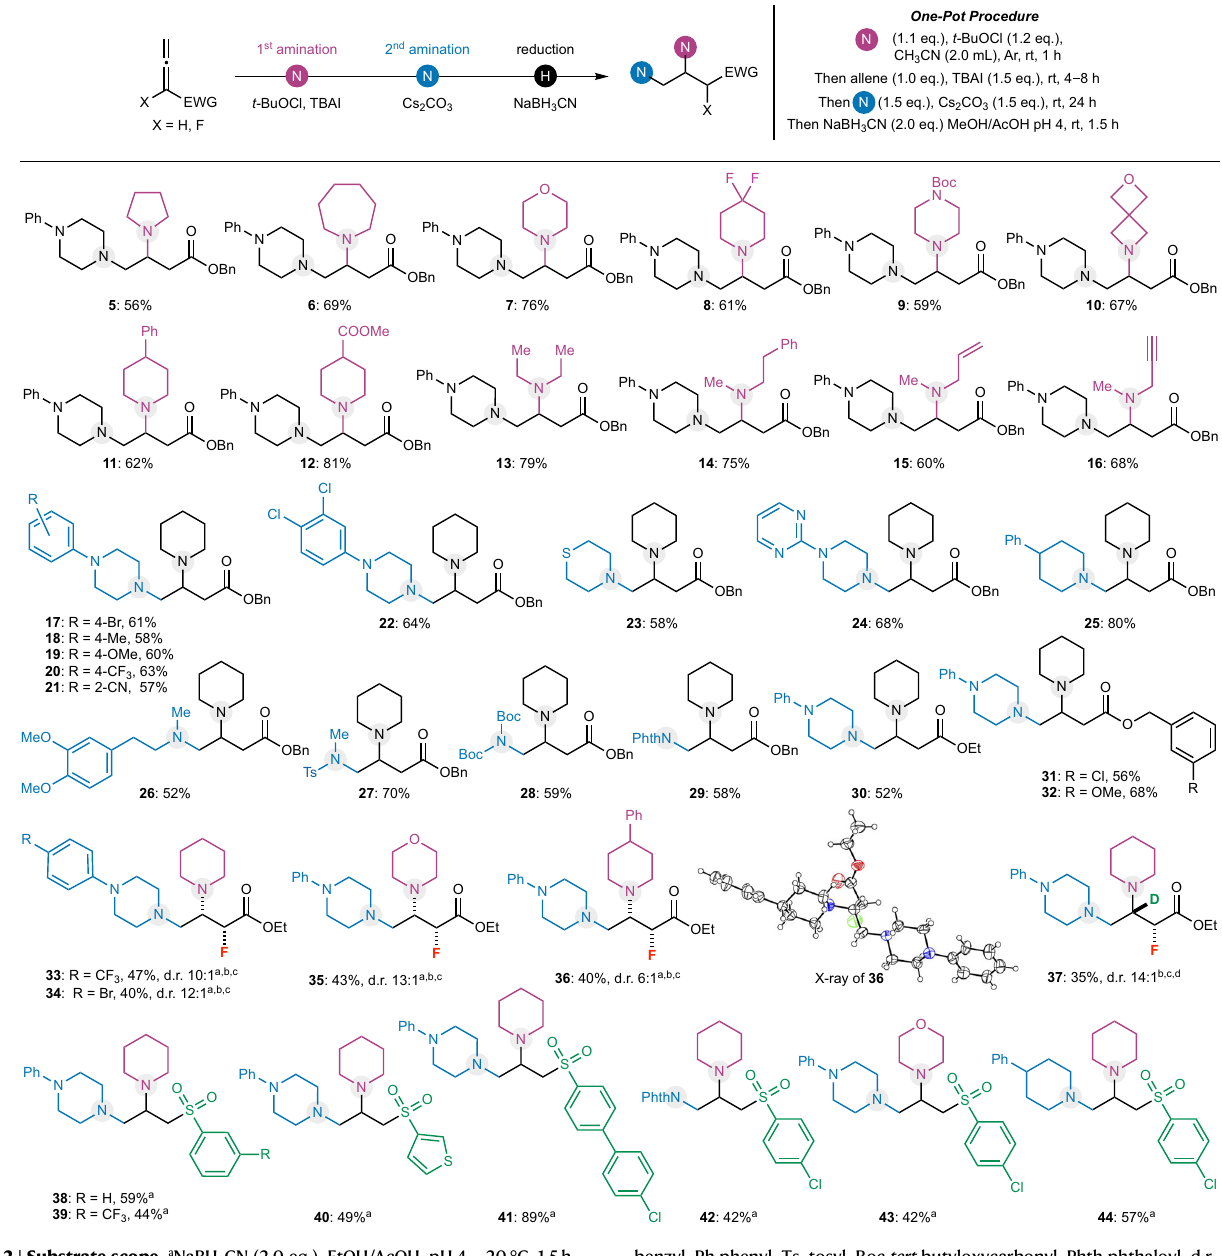
benzyl. Ph phenyl. Ts, tosyl. Boc tert -butyloxycarbonyl. Phth phthaloyl. d.r. diastereomeric